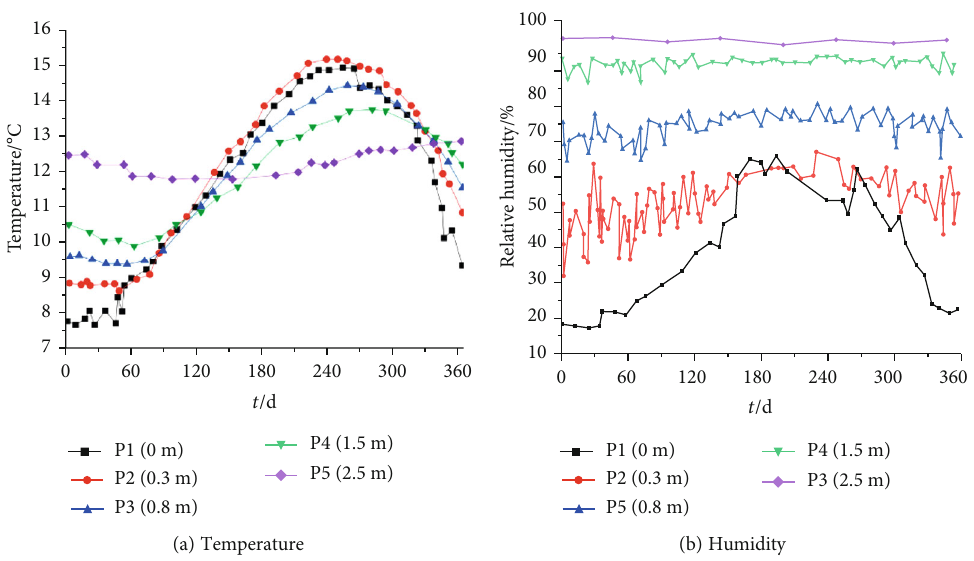
Figure 4: 108 environmental monitoring curve of occurrence in boreholes.